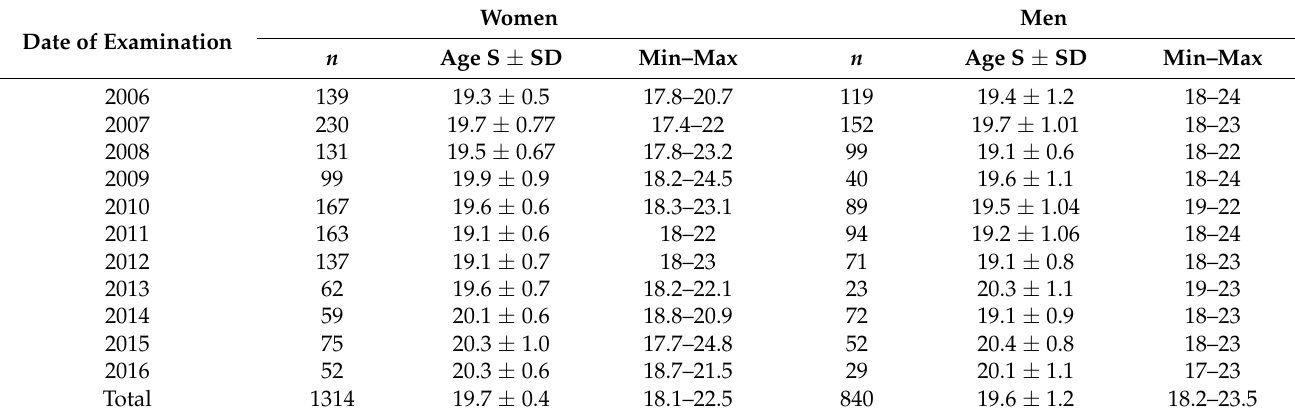
Table 1. Structure of the study group of women and men in the period between 2006 and